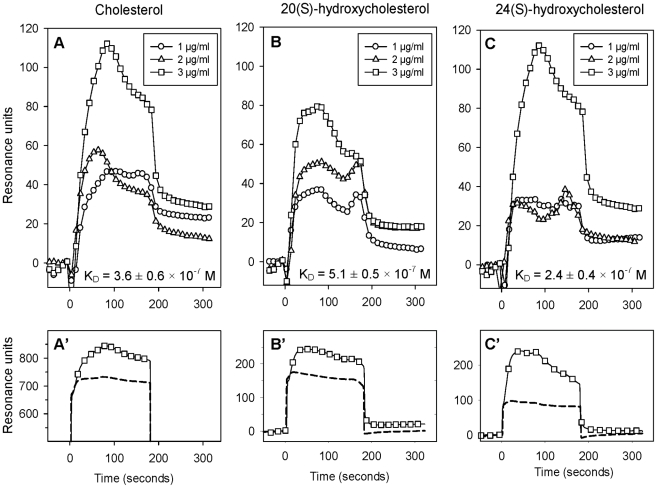
Binding of OxP-11D to cholesterol, 20(S)- and 24(S)-hydroxycholesterols.In panels A', B' and C' the dashed line shows binding of 3 µg/ml of the lipid to the biosensor's matrix and the line decorated with square symbols shows its binding to the sensor presenting OxP11-D. In panels A, B, and C, the results show binding isotherms corrected for background binding to the matrix.